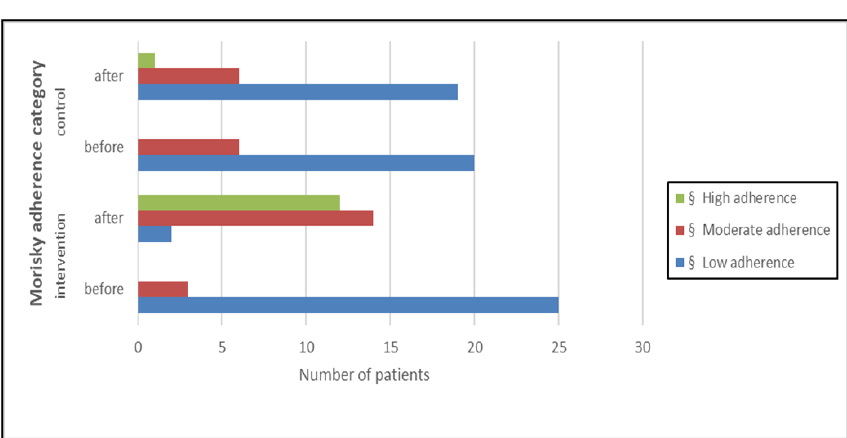
Fig. 6. Histograms showing the measured levels of adherence among the studied